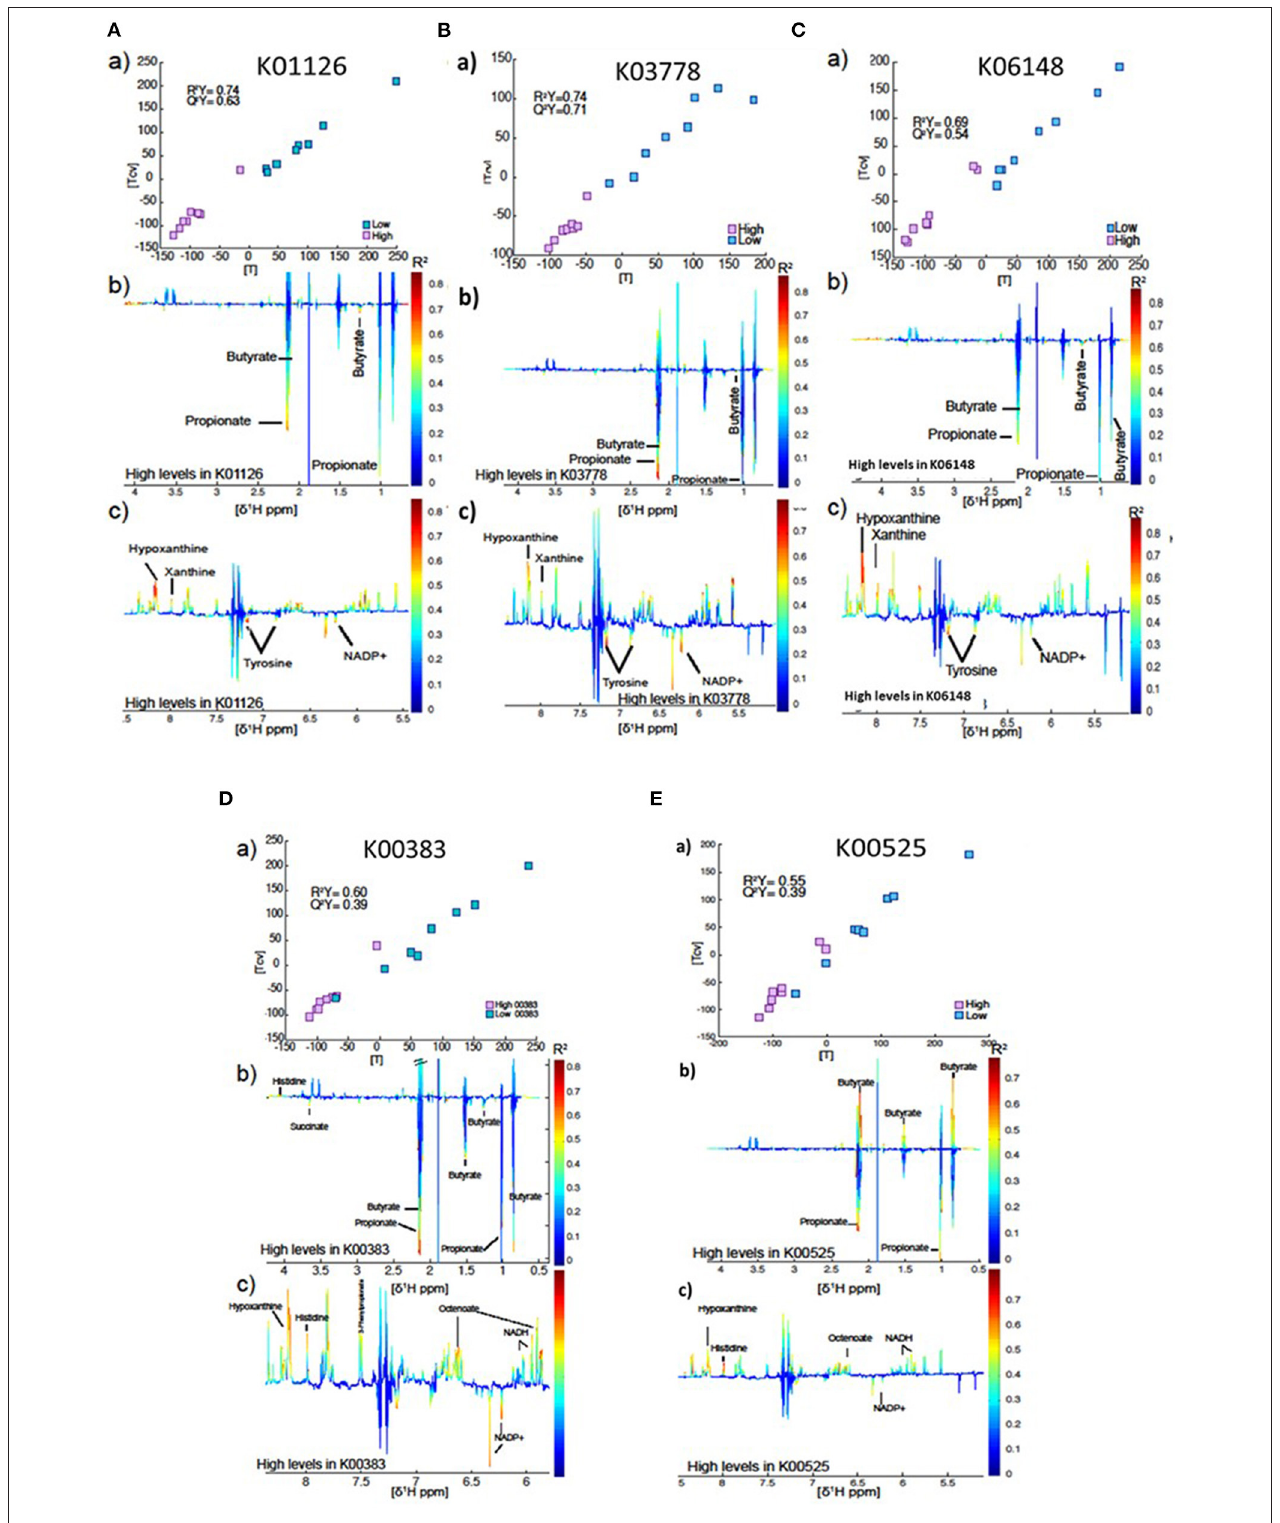
FIGURE 4 | (a) Plot of the scores against the cross validated scores generated from the O-PLS DA model calculated using 16 samples of the spectra as a matrix of independent variables and high vs. low gene index as predictor. (b,c) Aliphatic and aromatic regions of ruminal fluid spectra showing metabolomics differences between groups with high and low levels of the genes K01126 (A) , K03778 (B) , K06148 (C) , K00383 (D) , and K00525 (E) .